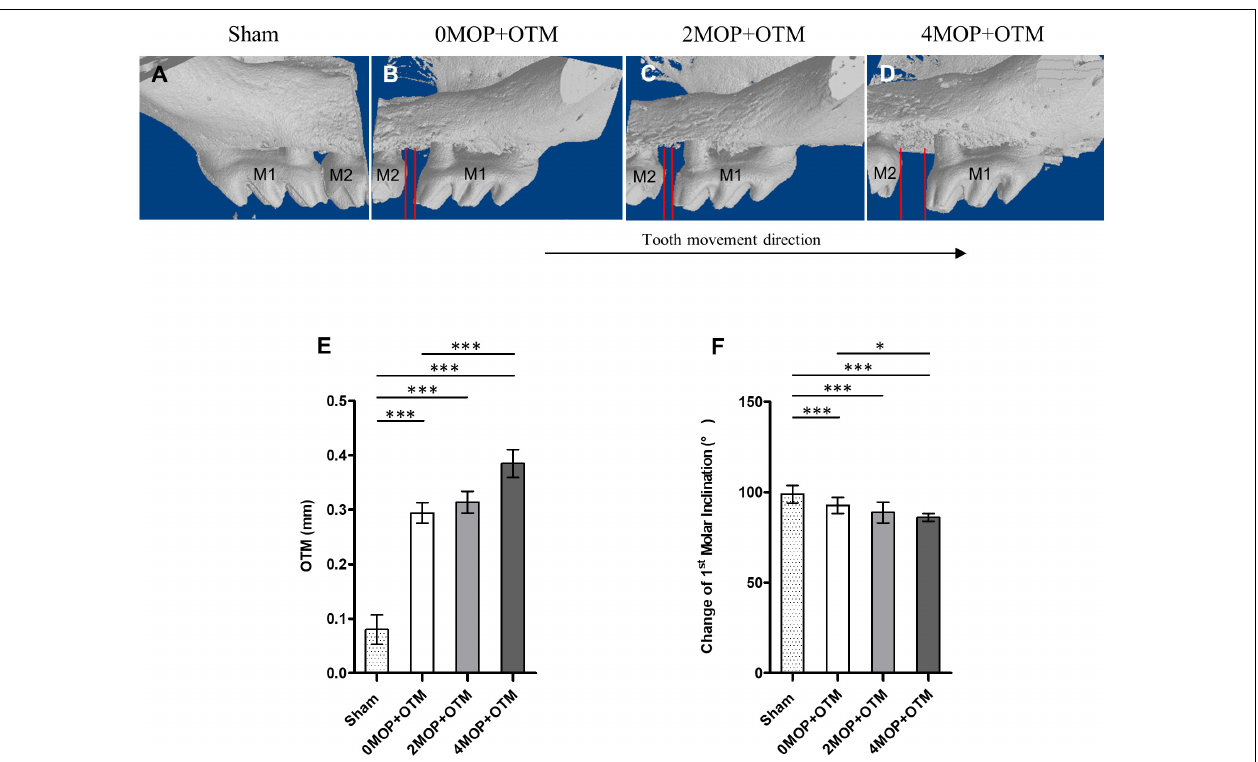
FIGURE 3 | Comparison of the tooth movement distance and molar inclination. (A–D) 3D volumetric model ( buccal side ) of maxillary molar showing comparison of tooth movement distance between the groups after the experimental period. (E) The Sham group (0.08 ± 0.02 mm; p < 0.001) decreased the distance of OTM compared with the 0MOP+OTM (0.29 ± 0.06 mm), 2MOP+OTM (0.31 ± 0.07 mm) and 4MOP+OTM (0.38 ± 0.08 mm) groups. The 4MOP+OTM group showed increased OTM ( p < 0.01) compared with the 0MOP+OTM group. (F) The Sham group exhibited increased 1st molar inclination (99.01 ± 4.91 ◦ ; p < 0.001) compared with the 0MOP+OTM (90.52 ± 6.59 ◦ ), 2MOP+OTM (88.74 ± 5.73 ◦ ) and 4MOP+OTM (84.2 ± 7.42 ◦ ) groups. The 4MOP+OTM group exhibited decreased OTM ( p < 0.05) compared with the 0MOP+OTM group. ( N = 12 for each group) (M1, 1st molar; M2, 2nd molar; red lines in (B–D) showed the tooth movement distance; data are expressed as mean ± standard deviation. Tested by Mann-Whitney U -test, ∗ p < 0.05; ∗∗∗ p < 0.001).